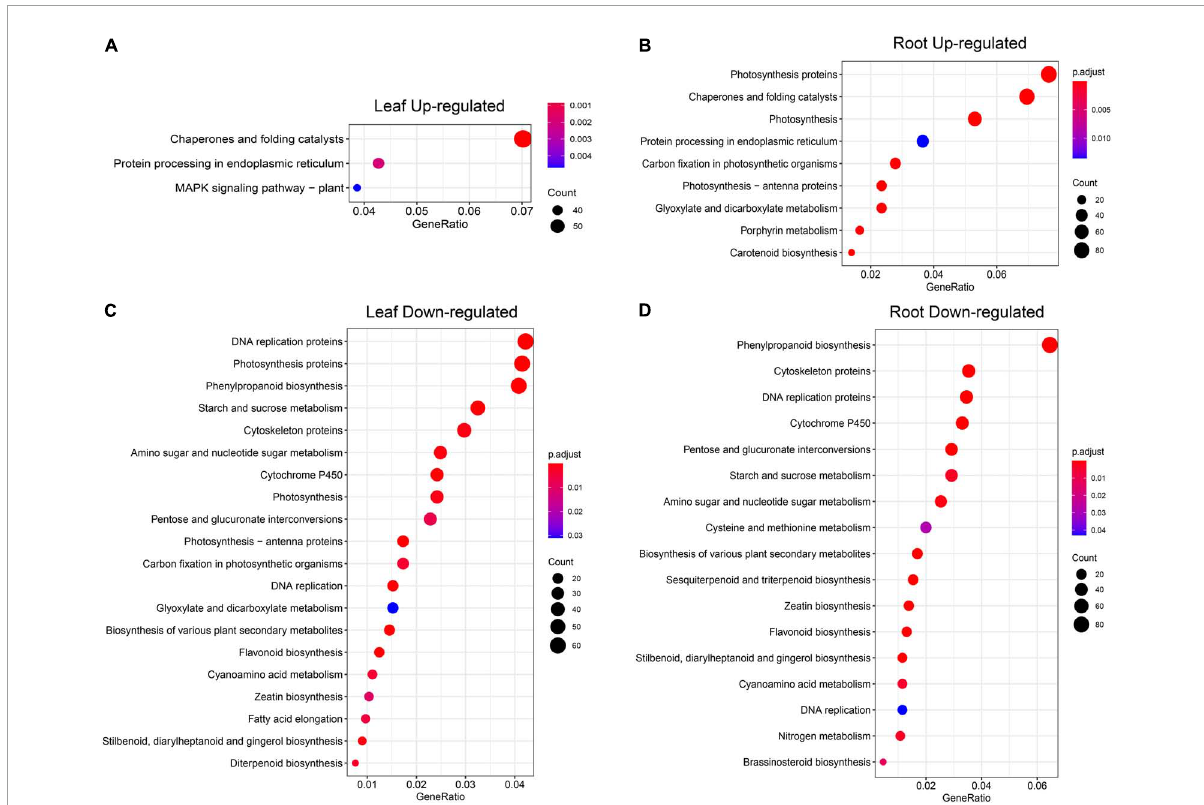
FIGURE8 KEGG pathway analysis of DEGs under heat stress. (A) Upregulated DEGs in the leaf. (B) Upregulated DEGs in the root. (C) Downregulated DEGs in the leaf. (D) Downregulated DEGs in the root. The full lists of pathway result in Supplementary Table 10